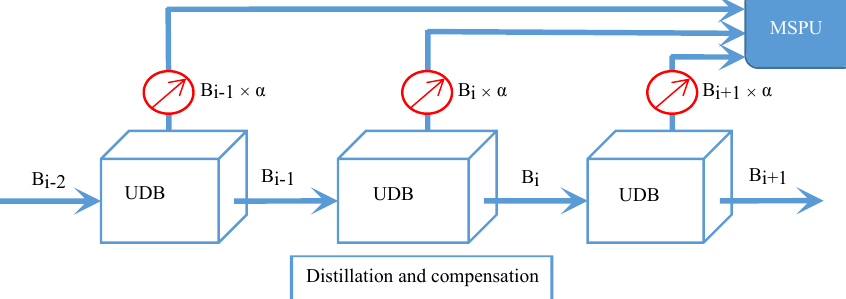
Figure 3. The distillation and compensation mechanism. The red components indicate that the distilled feature maps B i × α in current UDB are adaptively preserved. α denotes the distillation ratio for current UDB output B i . MSPU refers to the further purification